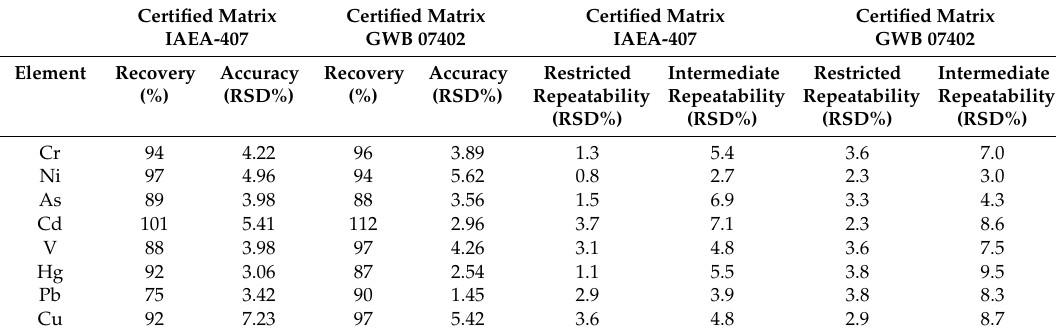
Table 3. Accuracy and precision performance for the certified